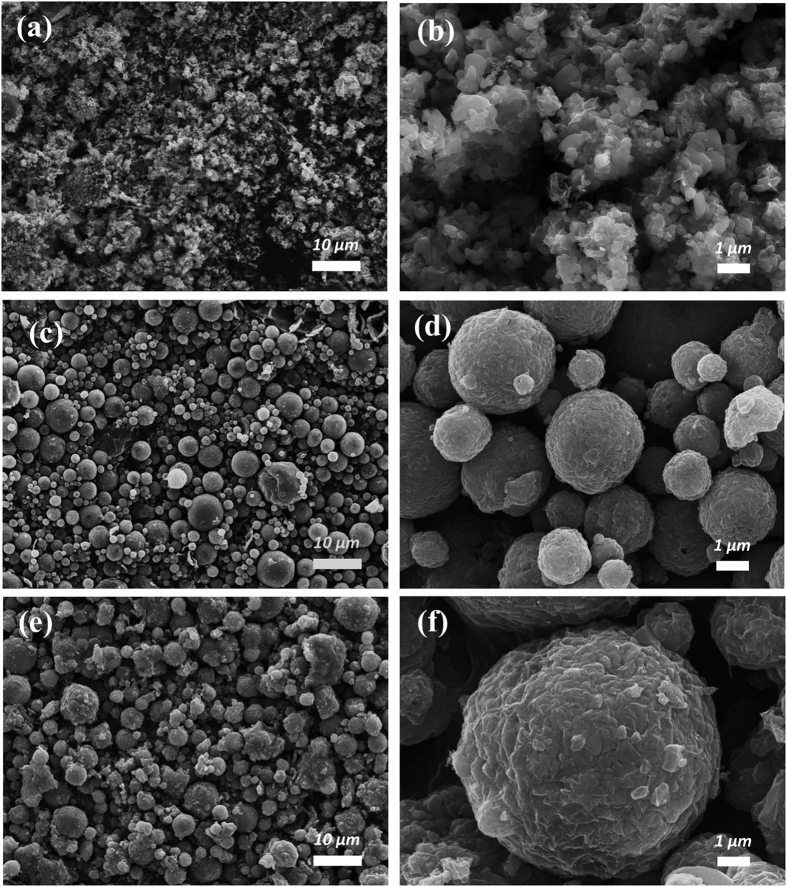
FE-SEM images of 3D LiMn0.75Fe0.25PO4/rGO microspheres prepared using different metal salts: (a,b) SO4_LMFP, (c,d) NO3_LMFP, and (e,f) Cl2_LMFP.